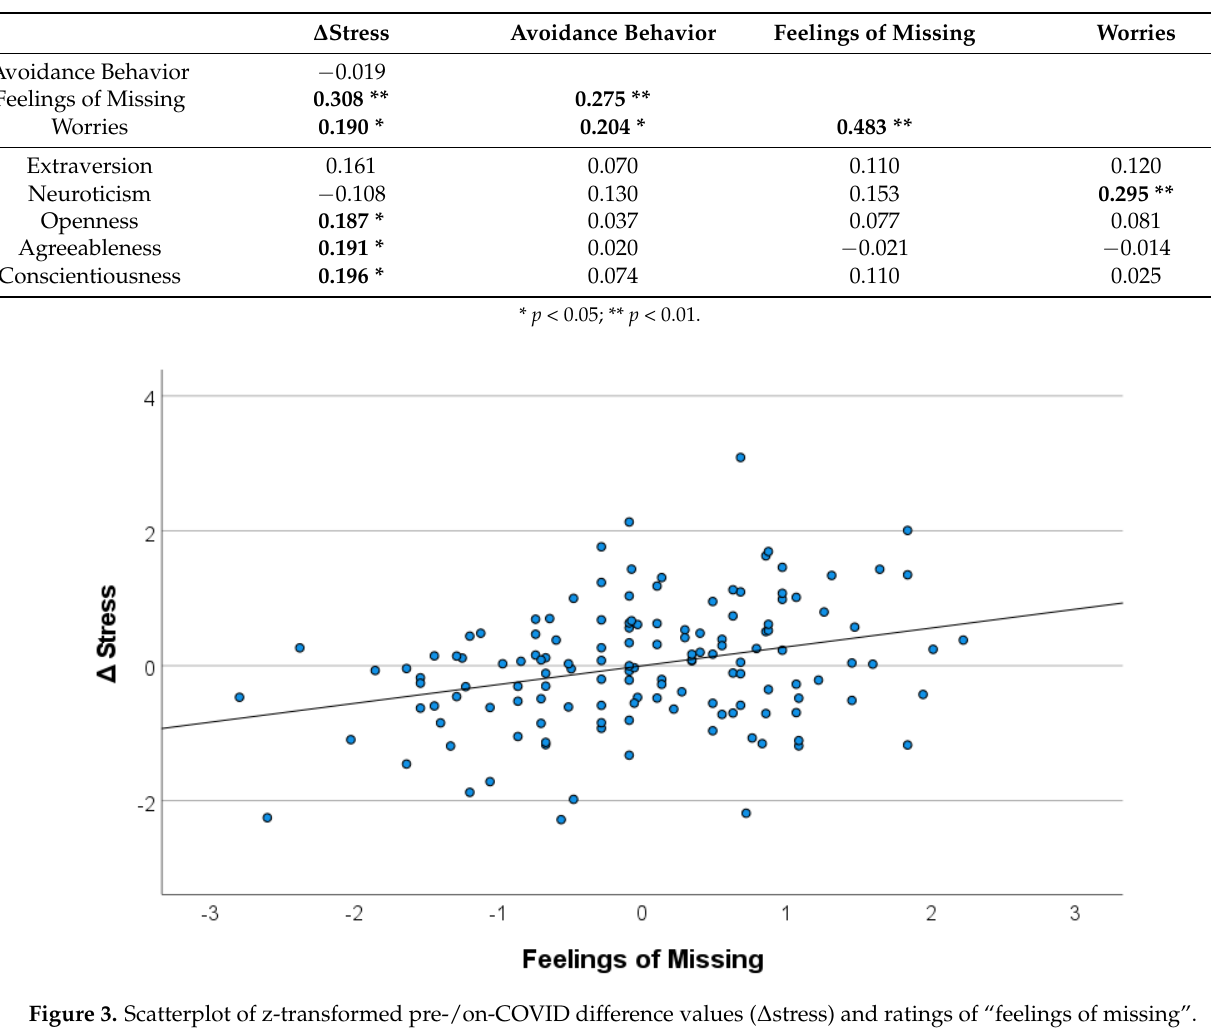
Figure 3. Scatterplot of z ‐ transformed pre ‐ /on ‐ COVID difference values ( Δ stress) and ratings of “feelings of missing”.